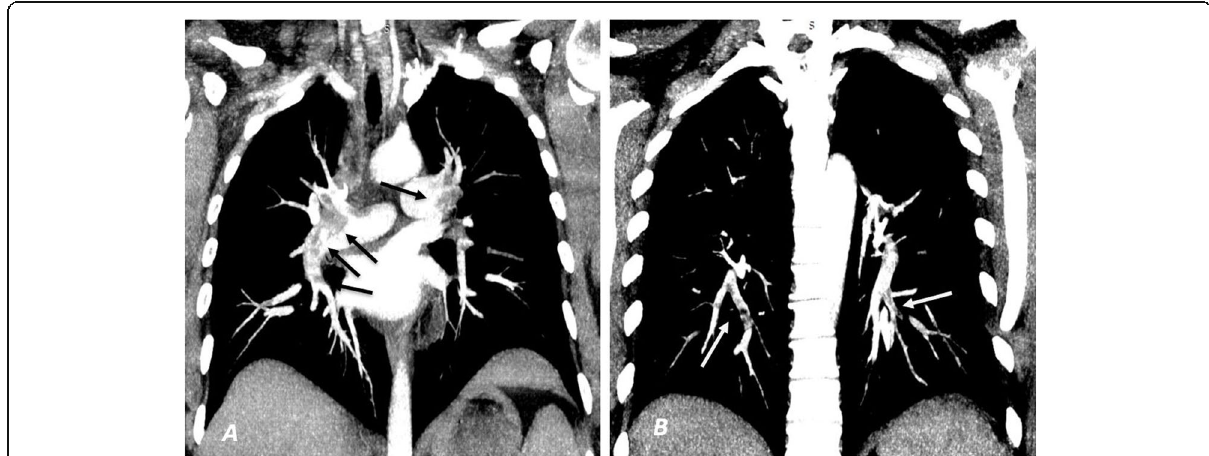
Fig. 5 a , b Coronal maximum intensity projection (MIP) images of the same patient in Fig. 4. A partial thrombus was noted involving the right and left main pulmonary arteries causing partial occlusion extending to involve the related lobar arteries (black arrows in a ). The thrombus was extending to involve the segmental branches of the lower lobar arteries bilaterally (white arrows in b